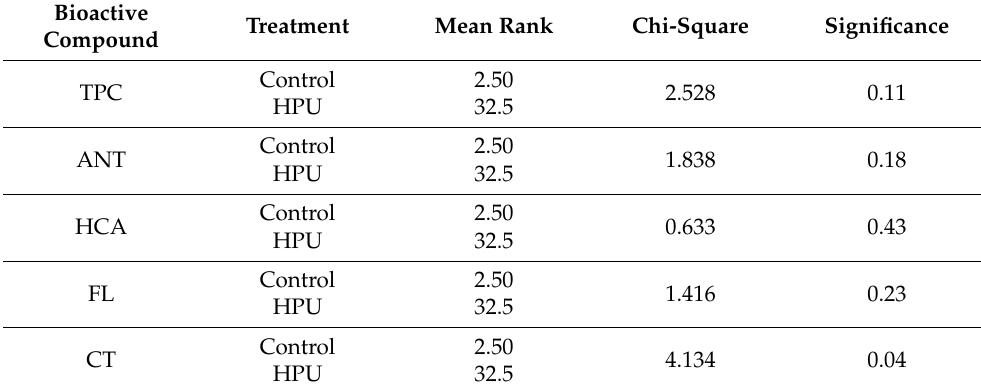
Table 2. Kruskal–Wallis test statistics for the HPU vs. control samples.